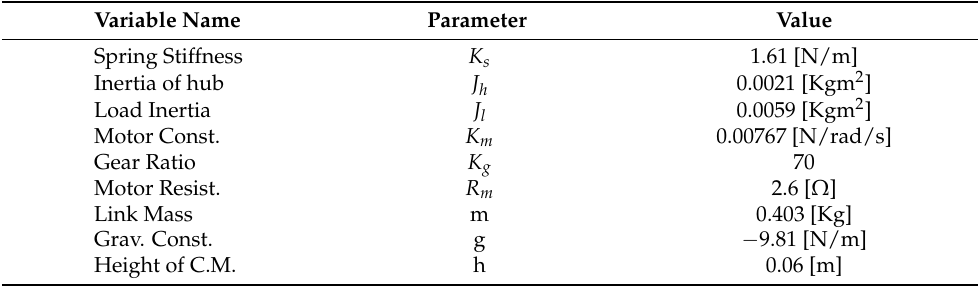
Table 1. Parameters value of the single-link with a flexible joint